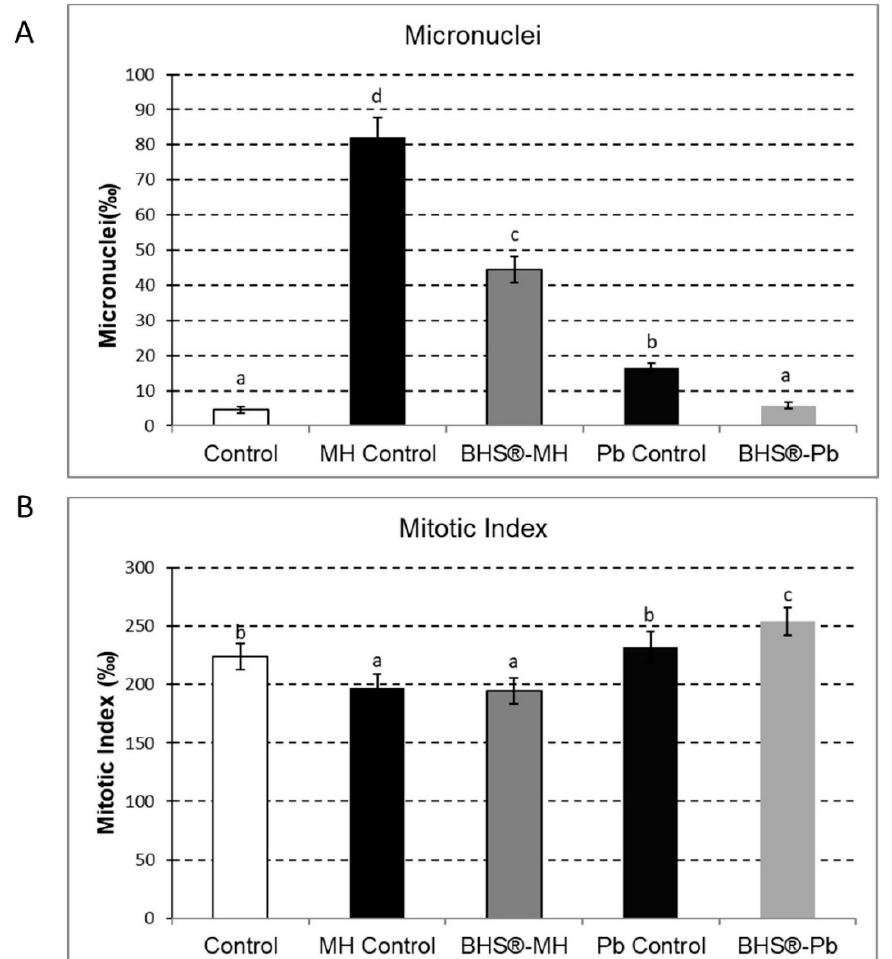
Figure 5. Assessment of the protective effect of BHS ® . Micronucleus frequency ( A ), expressed as number of micronuclei per 1000 cells observed and mitotic index ( B ) expressed as number of dividing cells per 1000 cells observed on the root apex of Vicia faba after 56 h of treatment: non-exposed (Control) or exposed to 10 − 5 M Maleic hydrazide (MH Control) or lead (Pb Control) or exposed to BHS ® and to MH (BHS ® -MH), (Histograms marked with the same letter are not statistically different at p < 0.05).